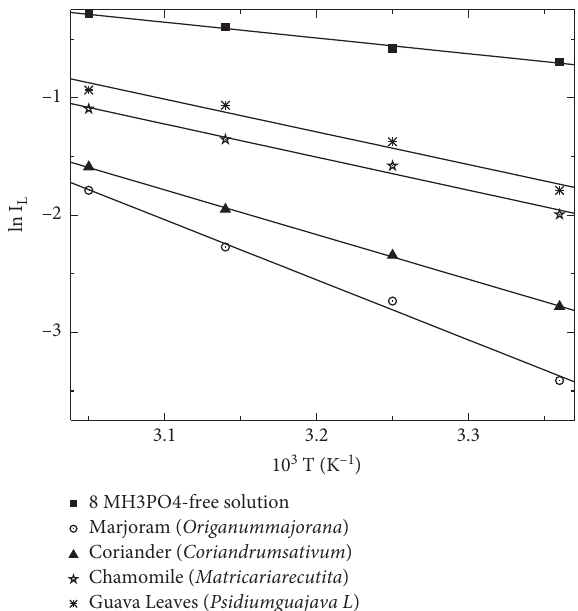
Figure 9: Arrhenius plot of the dissolution process recorded for the carbon steel plate in 8 M H 3 PO 4 in the absence and presence of 1800ppm of the four plant